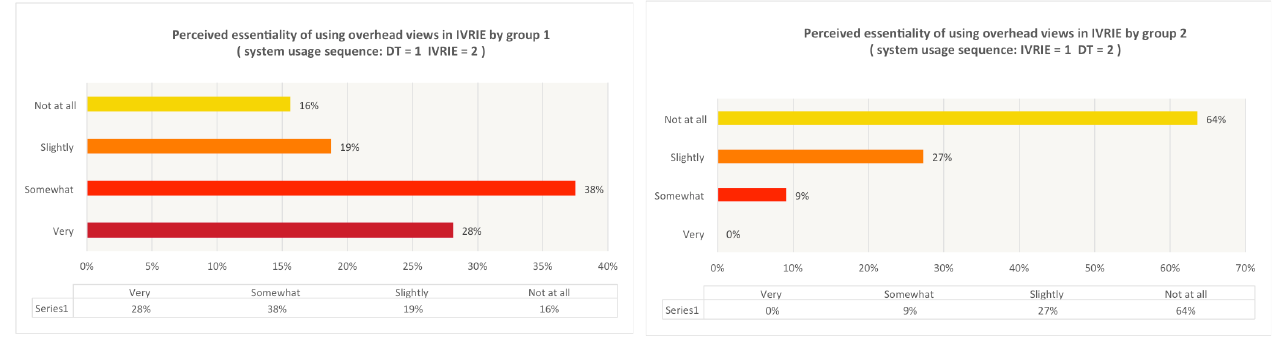
Figure 11 . Evaluations of the need for the overhead view for both groups and with opposite system usage sequences.